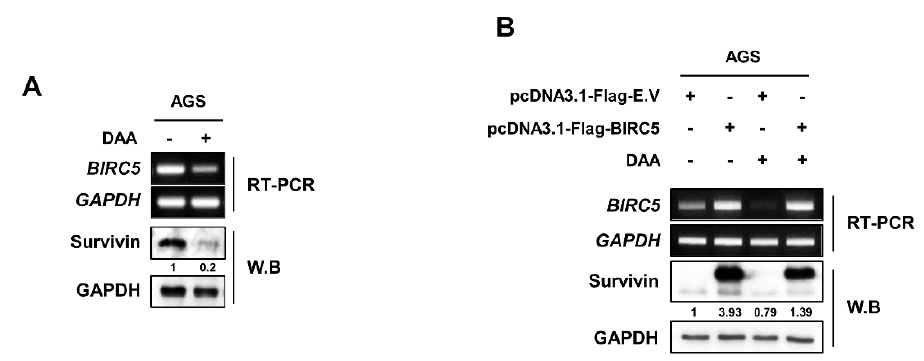
Figure 3. DAA specifically reduced the expression level of survivin. ( A ) Detection of mRNA and protein expression of survivin in AGS cells with 85 µM DAA treatment for 48 h using by RT-PCR and Western blotting. ( B ) The overexpression of survivin and the inhibitory effect of DAA were determined. Survivin was overexpressed in AGS cells using a plasmid system; survivin-overexpressing AGS cells were treated with 85 µM of DAA for 48 h.